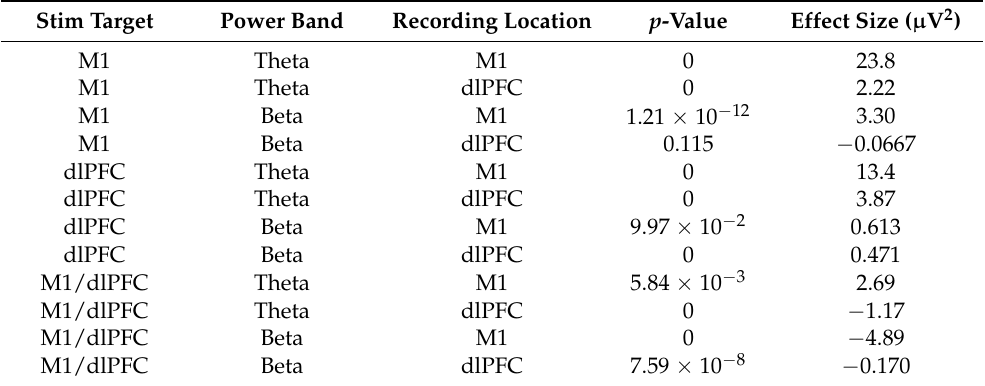
Table 1. GLME results showing effect of stimulation on theta- (6–9 Hz) and low beta-band (13–20 Hz)